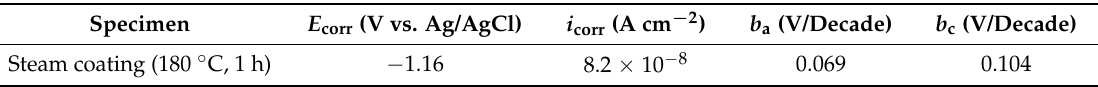
Figure 11. ( a ) Polarization curves of as ‐ received specimen and specimen subjected to steam coating at 180 °C for 1 h after the saltwater immersion for 48 h. ( b ) Appearance of surface of as ‐ received specimen and that subjected to steam coating at 180 °C for 1 h, before and after immersion corrosion test in an NaCl solution for 48 h. Table 3. Tafel plot measurement of potentiodynamic polarization curves of as ‐ received and film ‐ coated specimens after immersion in NaCl solution for 48 h.